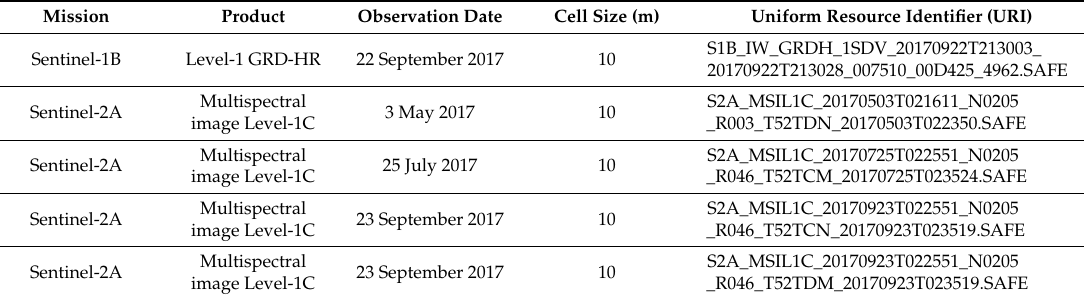
Table 1. List of Sentinel imagery acquired for the study.